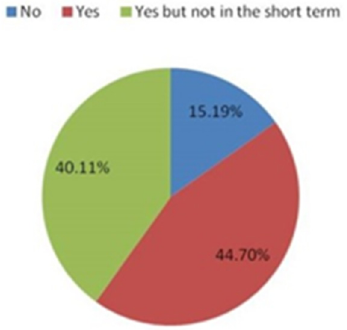
Figure 1. Replies to the question, “Does Climate Change Impact Your Life?”.